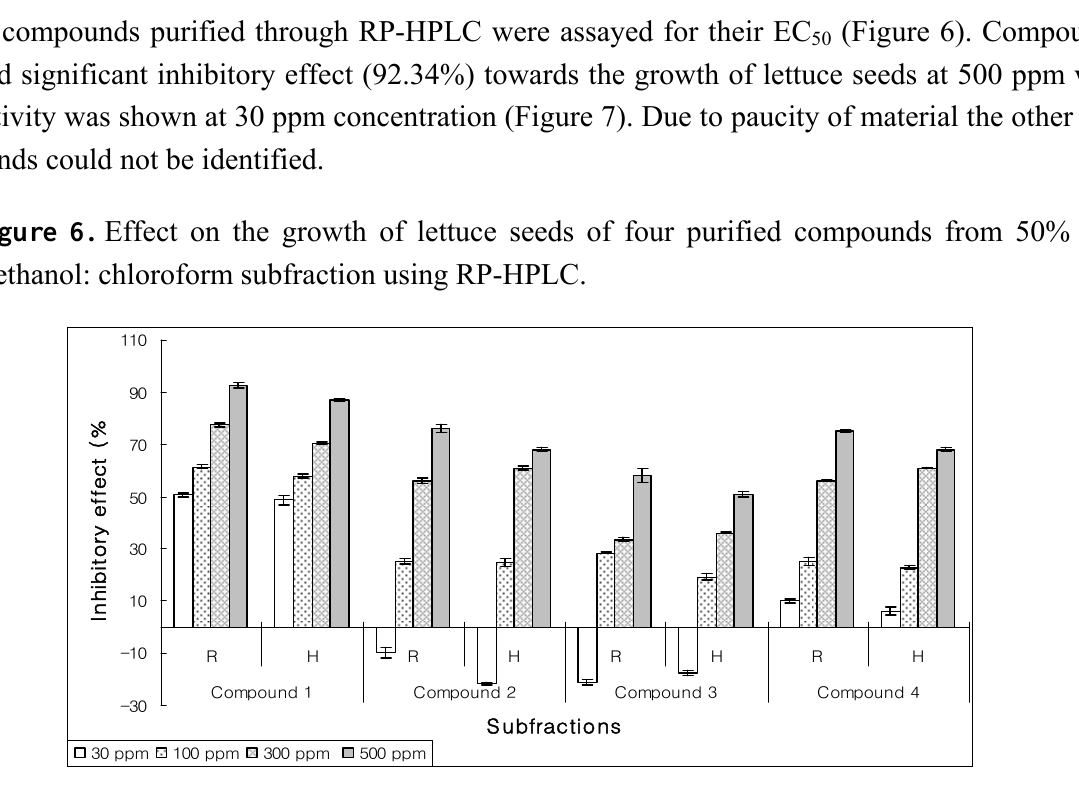
Figure 7. Inhibitory effect of compound ( 1 ) on the growth of root (R) and hypocotyls (H) of